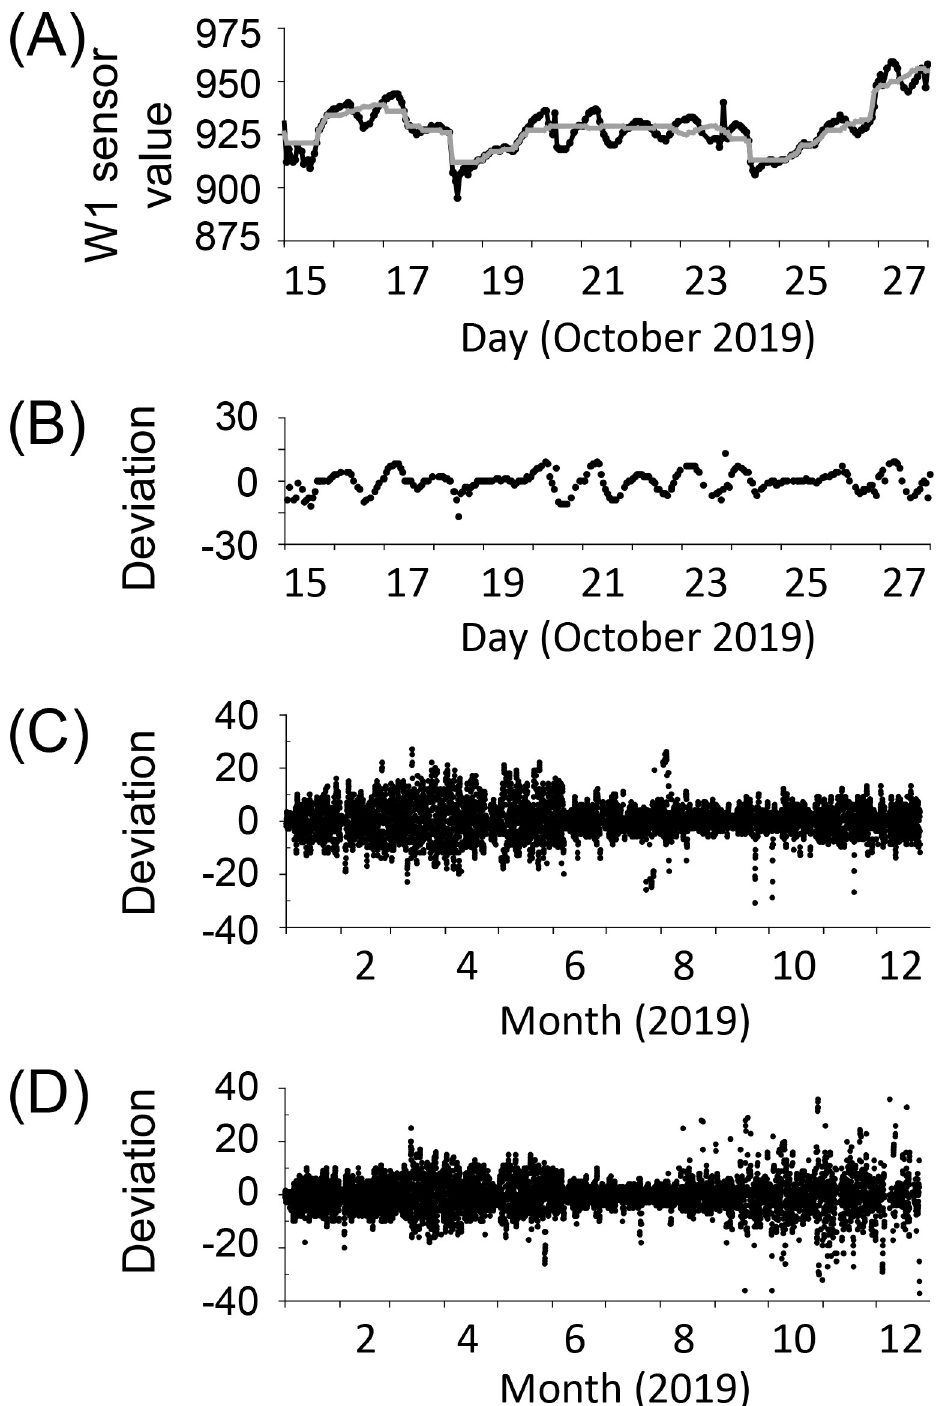
Fig 3. Sensor signal processing and deviation computed in Gyeongju. (A) Generation of baseline sensor values (gray line) from raw sensor values (black line) by applying a median filter. (B) Computed deviation, i.e., difference between the baseline and measured sensor values. (C) Annual change in the deviation of an uninfected tree. (D) Annual change in the deviation of an infected tree.